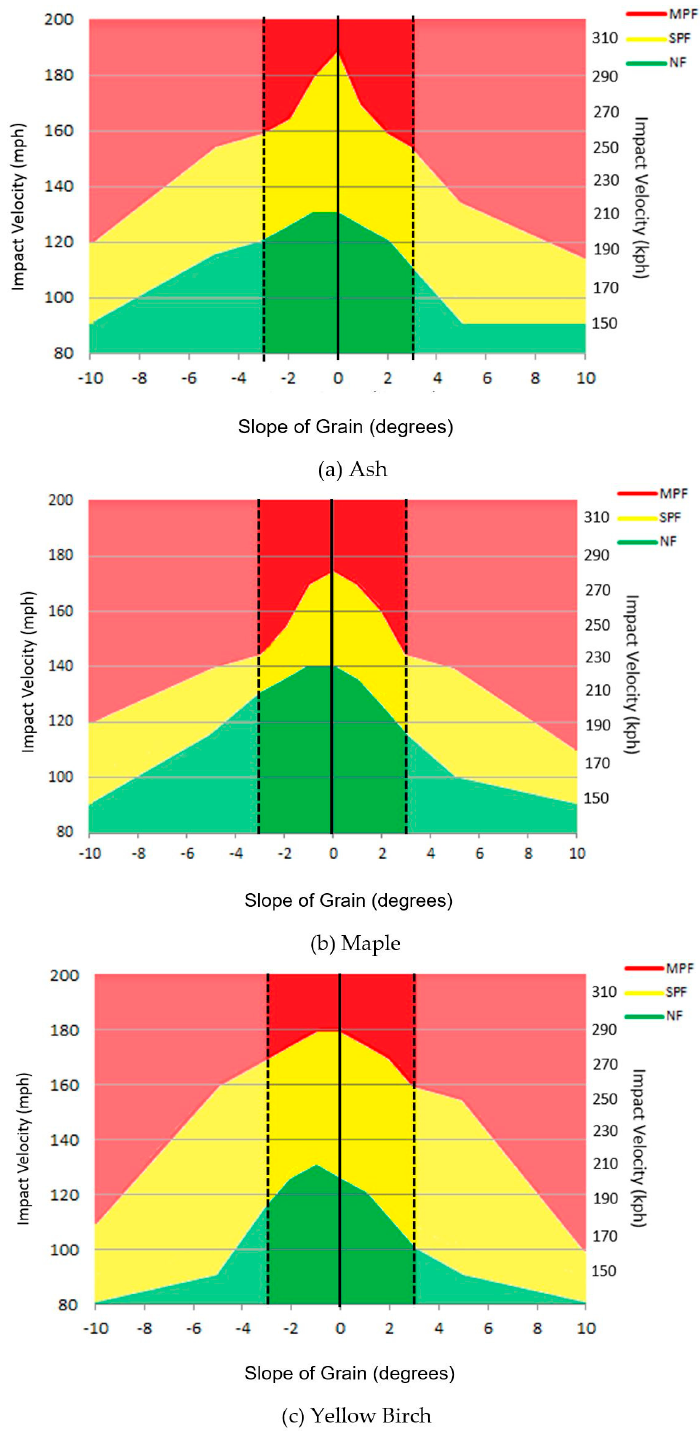
Figure 10. 2 in. (5.1 cm) impact model set results for ( a ) Ash, ( b ) Maple, and ( c ) Yellow Birch.